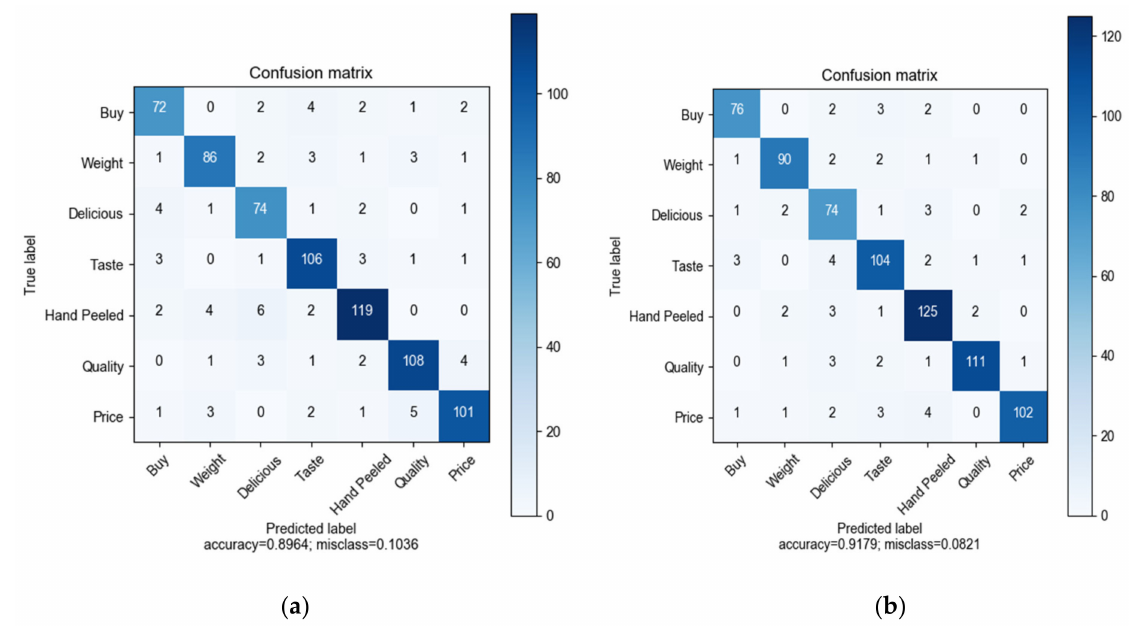
Figure 7. Confusion matrix comparison chart. ( a ) the confusion matrix diagram of the BiLSTM-Self- Attention. ( b ) the confusion matrix diagram of the